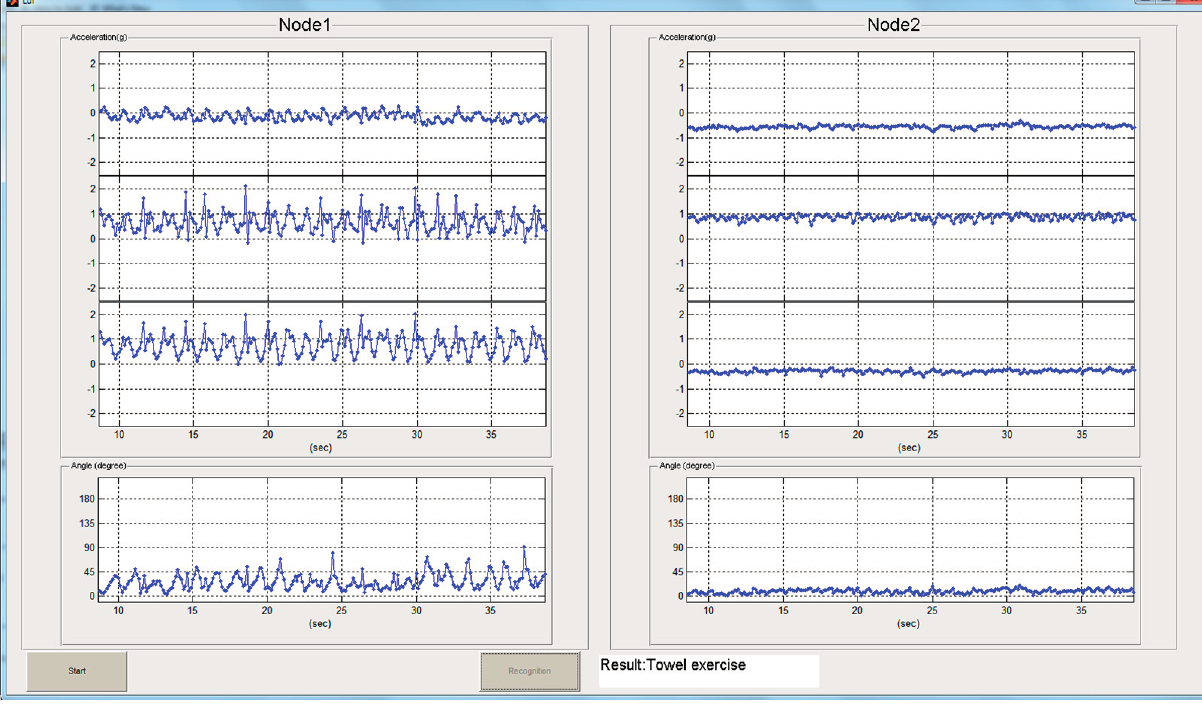
Figure 12. Real-time interface of the activity recognition model for frozen shoulder rehabilitation returns the result of the assigned exercise that is arbitrarily made by the user and detected by the WSN